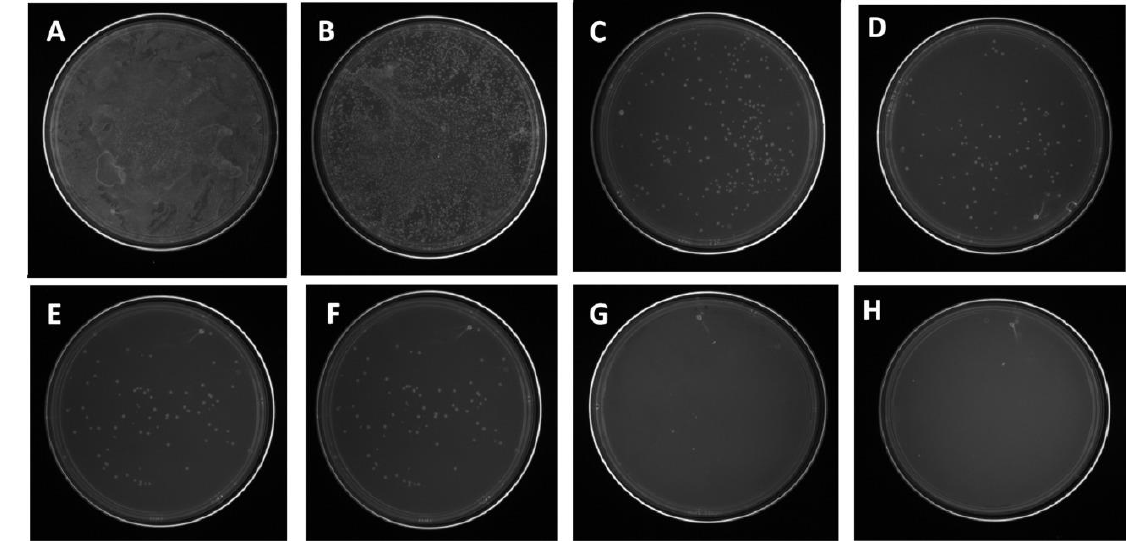
Figure 5. Effects of nanofiber concentrations on the viability of antibiotic-resistant GFP Escherichia coli : ( A ) PEO–PCL nanofiber and ( B – H ) 1, 2, 4, 6, 7, 8, and 10 mg of composite nanofiber (adapted with permission from reference [17]).